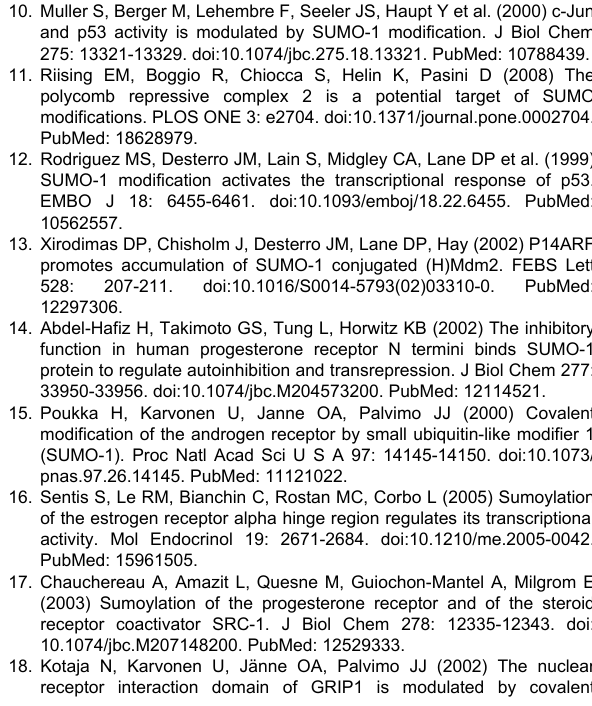
Figure S1. UBC9 expression in MCF-7 and MDA-MB-231 breast cancer cell lines. ( A ) UBC9 mRNA expression in ER- positive MCF-7 and ER-negative MDA-MB-231 breast cancer cells. Total RNA was isolated and analysed by real-time RT- PCR. Expression levels were normalized to GAPDH